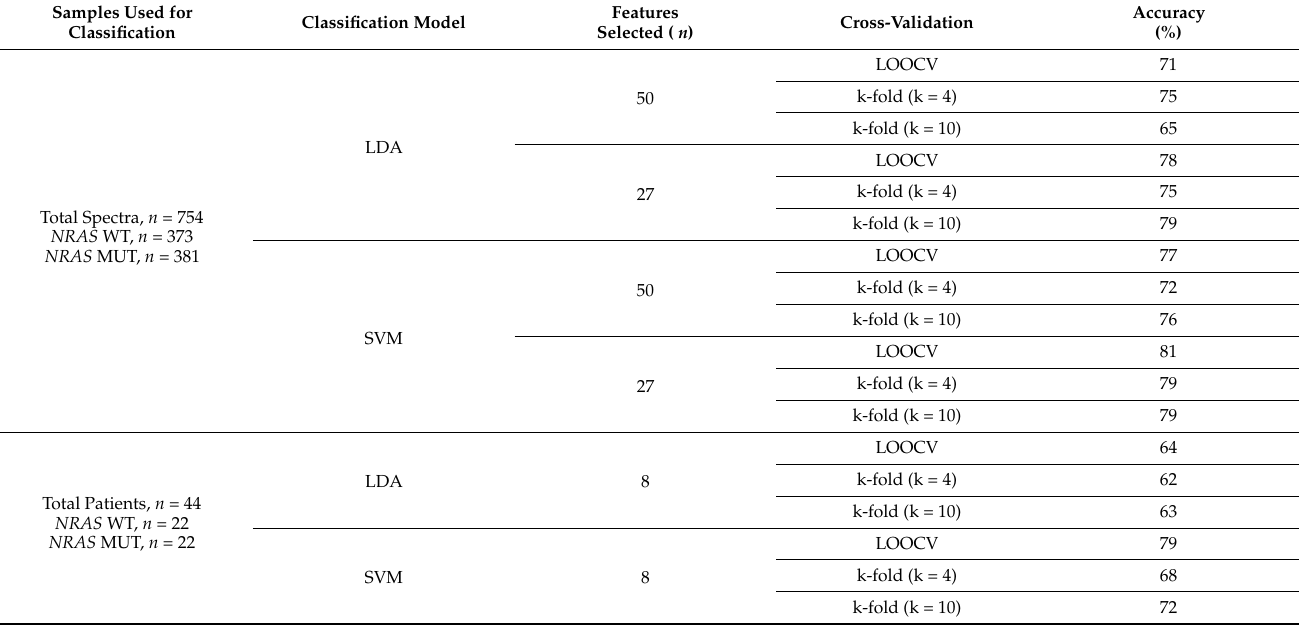
Table 4. Classification analysis to discriminate NRAS (neuroblastoma RAS viral oncogene homolog) mutated ( NRAS MUT) from NRAS wildtype ( NRAS WT) samples based on m / z features selected by forward feature selection (FFS). Each classification model classified individual spectra and individual patients. Two different classification models are used: linear discriminant analysis (LDA) and support vector machine (SVM). For each model, two cross-validation methods were calculated: leave-one-out cross-validation (LOOCV) and k-fold (k = 4, k = 10) cross-validation.